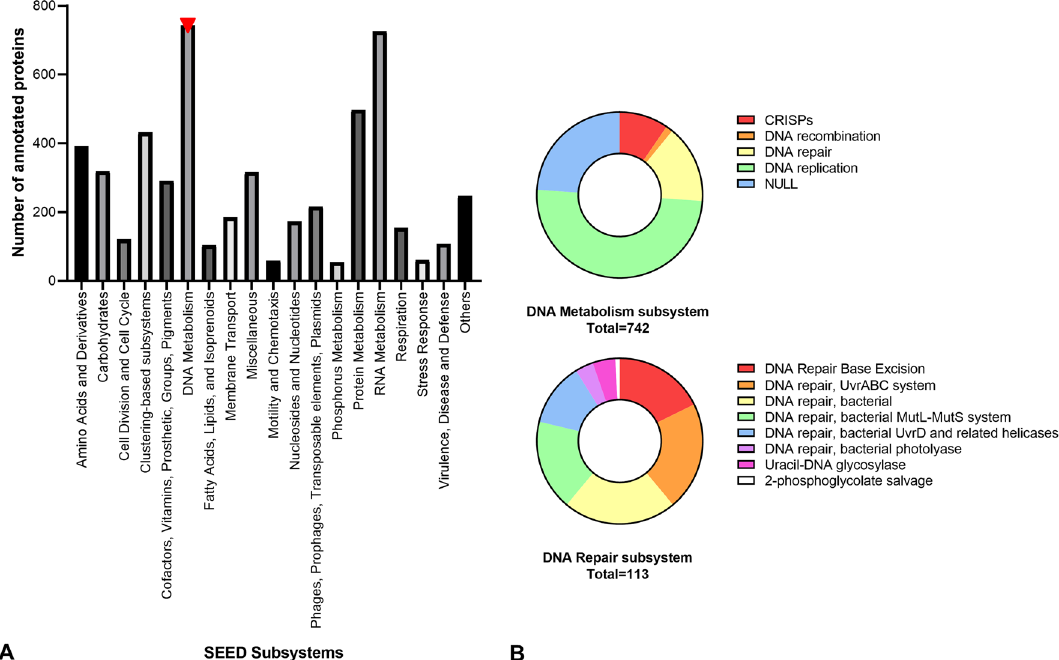
Figure 2. Predicted functional profile of the Diamante Lake plasmidome. ( A ) Number of annotated proteins of each of the major SEED subsystems by using a maximum E -value of 10 –5 . SEED subsystems with less than 50 hits were grouped into “Others”. ( B ) On top, “DNA Metabolism” subsystem level 2 classification of the SEED database. On the bottom, “DNA Repair” subsystem level 3 classification of the SEED database ( E -value ≤ 10 –5